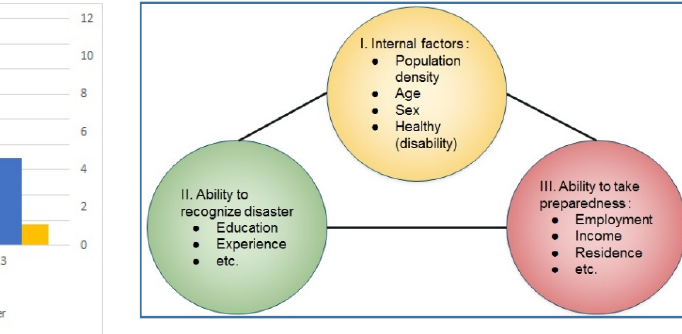
Figure 11. Diagram of factors affecting SoVI 3.5 The differences between the model of Frigerio, I., et al. (2016) and BNPB (2012)